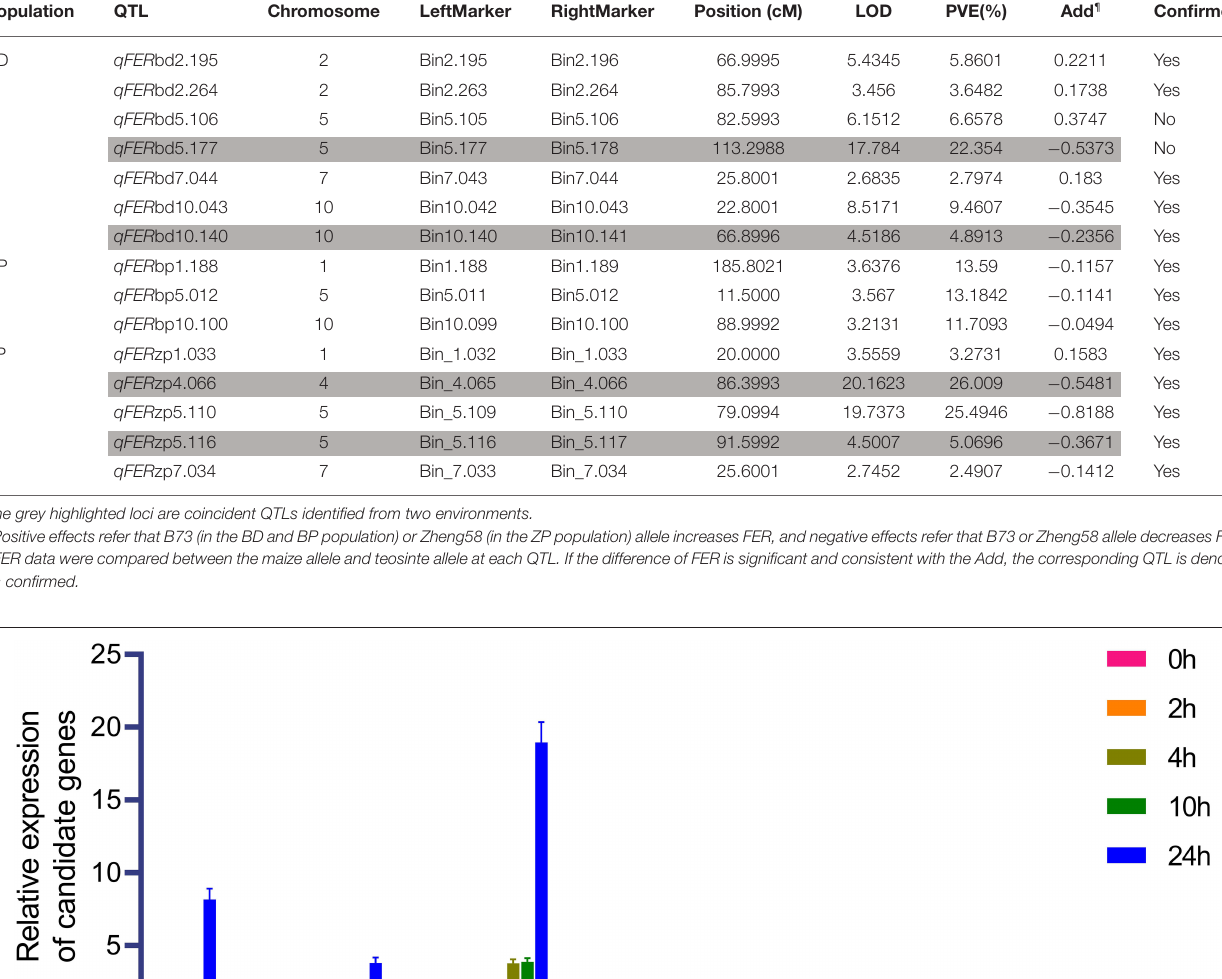
TABLE 4 | Significant QTLs for FER in three populations based on data collected in 2 years. Population